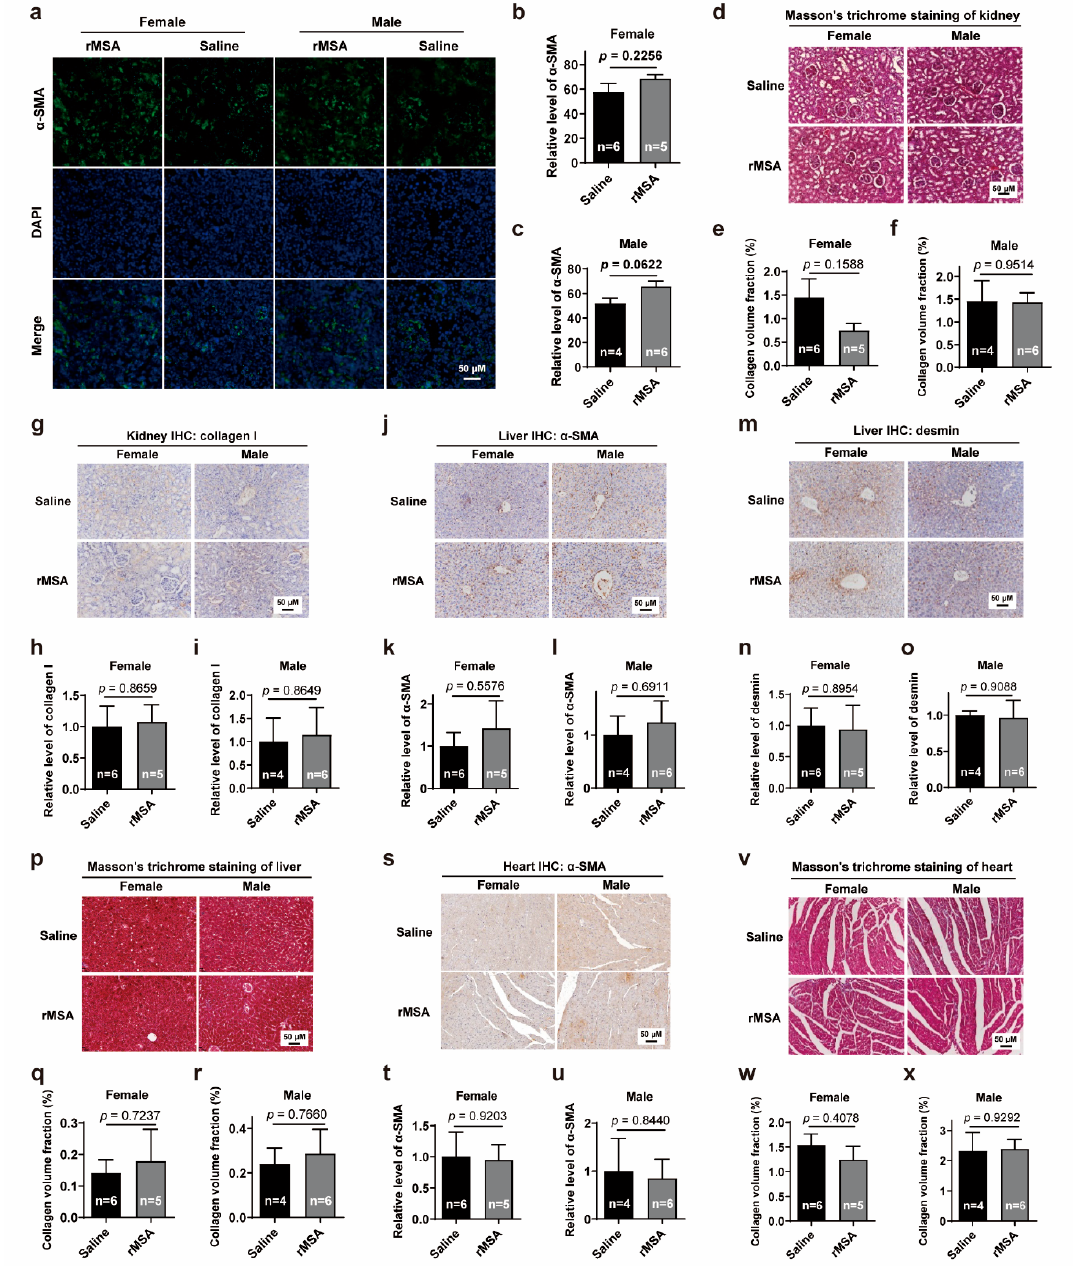
Figure 5. Effects of rMSA injection on the fibrosis level of kidney, liver and heart ( a ) The representative images of α -SMA in mice kidney. Scale bar, 50 µ m. ( b , c ) The quantitative results of α -SMA level in female ( b ) and male ( c ) mice. ( d ) The Masson’s trichrome staining of mice kidney. Scale bar, 50 μ m. ( e , f ) The collagen volume fraction of the kidney in female ( e ) and male ( f ) mice. ( g ) The immunohistochemical staining for collagen I in mice kidney. Scale bar, 50 μ m. ( h , i ) The relative level of collagen I in female ( h ) and male ( i ) mice. ( j ) The immunohistochemical staining for α -SMA in mice liver. Scale bar, 50 µ m. ( k , l ) The relative level of α -SMA in female ( k ) and male ( l ) mice. ( m ) The immunohistochemical staining for desmin in mice liver. Scale bar, 50 µ m. ( n , o ) The relative level of desmin in female ( n ) and male ( o ) mice. ( p ) The Masson’s trichrome staining of mice liver. Scale bar, 50 µ m. ( q , r ) The collagen volume fraction of the liver in female ( q ) and male ( r ) mice. ( s ) The immunohistochemical staining for α -SMA in mice heart. Scale bar, 50 μ m. ( t , u ) The relative level of α -SMA in female ( t ) and male ( u ) mice. ( v ) The Masson’s trichrome staining of mice cardiac muscle. Scale bar, 50 μ m. ( w , x ) The collagen volume fraction of the cardiac muscle in female ( w ) and male ( x ) mice. All graphs represent mean with SEM, with p values calculated by the two-tail t test. n, number of mice used for each analysis.